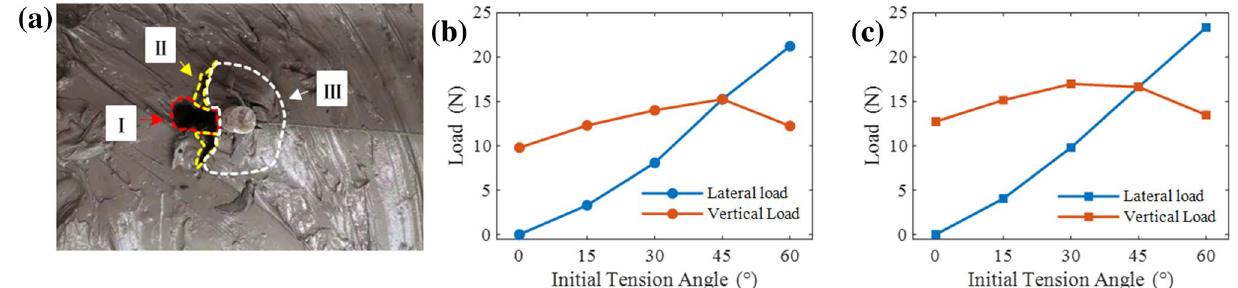
Figure 6. Photo of clay deformation (circular single pile, θ = 60°) before failure ( a ). Relationship between the lateral and vertical components of anchor pile failure load with the initial tension angle circular single pile ( b ) and square single pile ( c